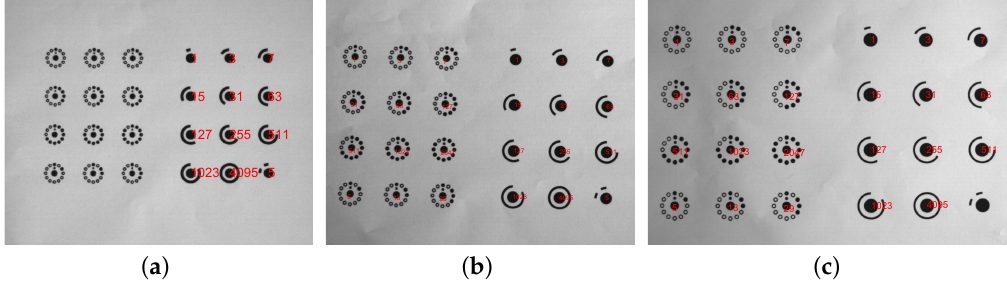
Figure 6. The contrast experiment of the size of the marked point. ( a ) The size of the occupied pixel ratio is 0.21%; ( b ) The size of the occupied pixel ratio is 0.34%; ( c ) The size of the occupied pixel ratio is 0.55%.